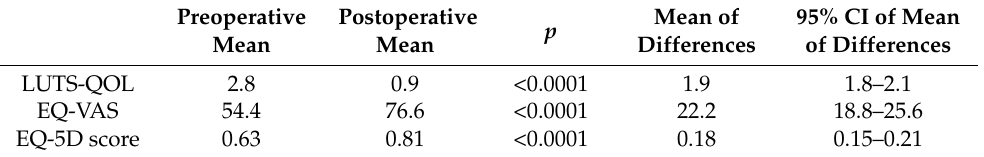
Table 10. Comparison of preoperative and postoperative